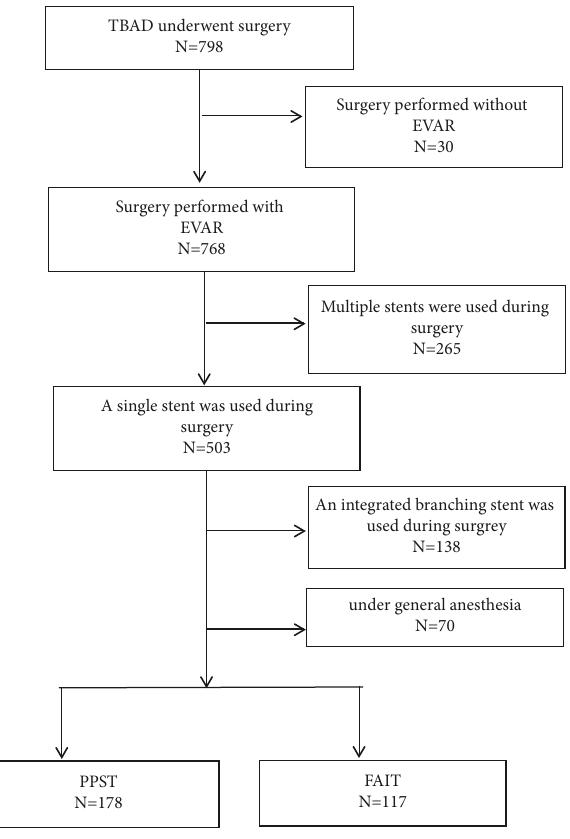
Figure 1: A consort type diagram of whole patients with TBAD who underwent